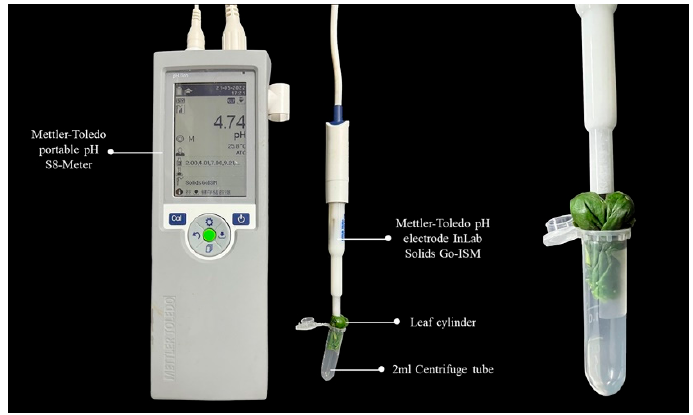
Figure 1. Illustration of leaf pH measurement with non-grinding method.